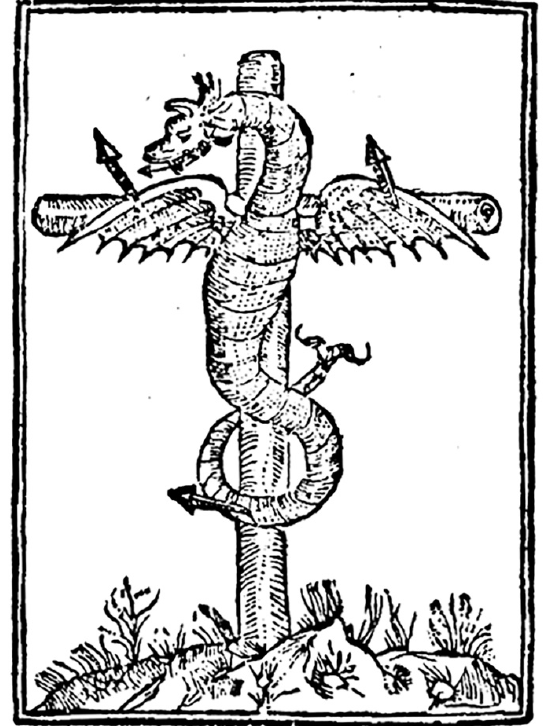
Figure 4. Anonymous. Serpiente de bronce , Pedro de Medina: Victoria gloriosa, y excelencias de la esclarecida Cruz de Iesu Christo …, p. 81.